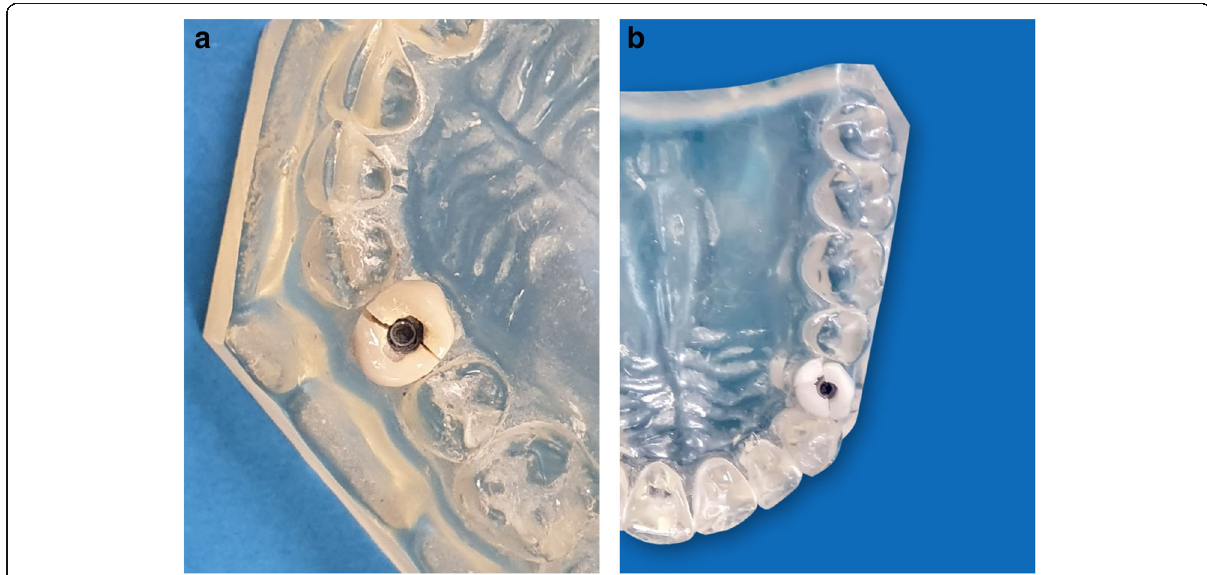
Fig. 2 Failure modes of hybrid-abutment-restorations. a The fracture was either two halves, b or three fragments